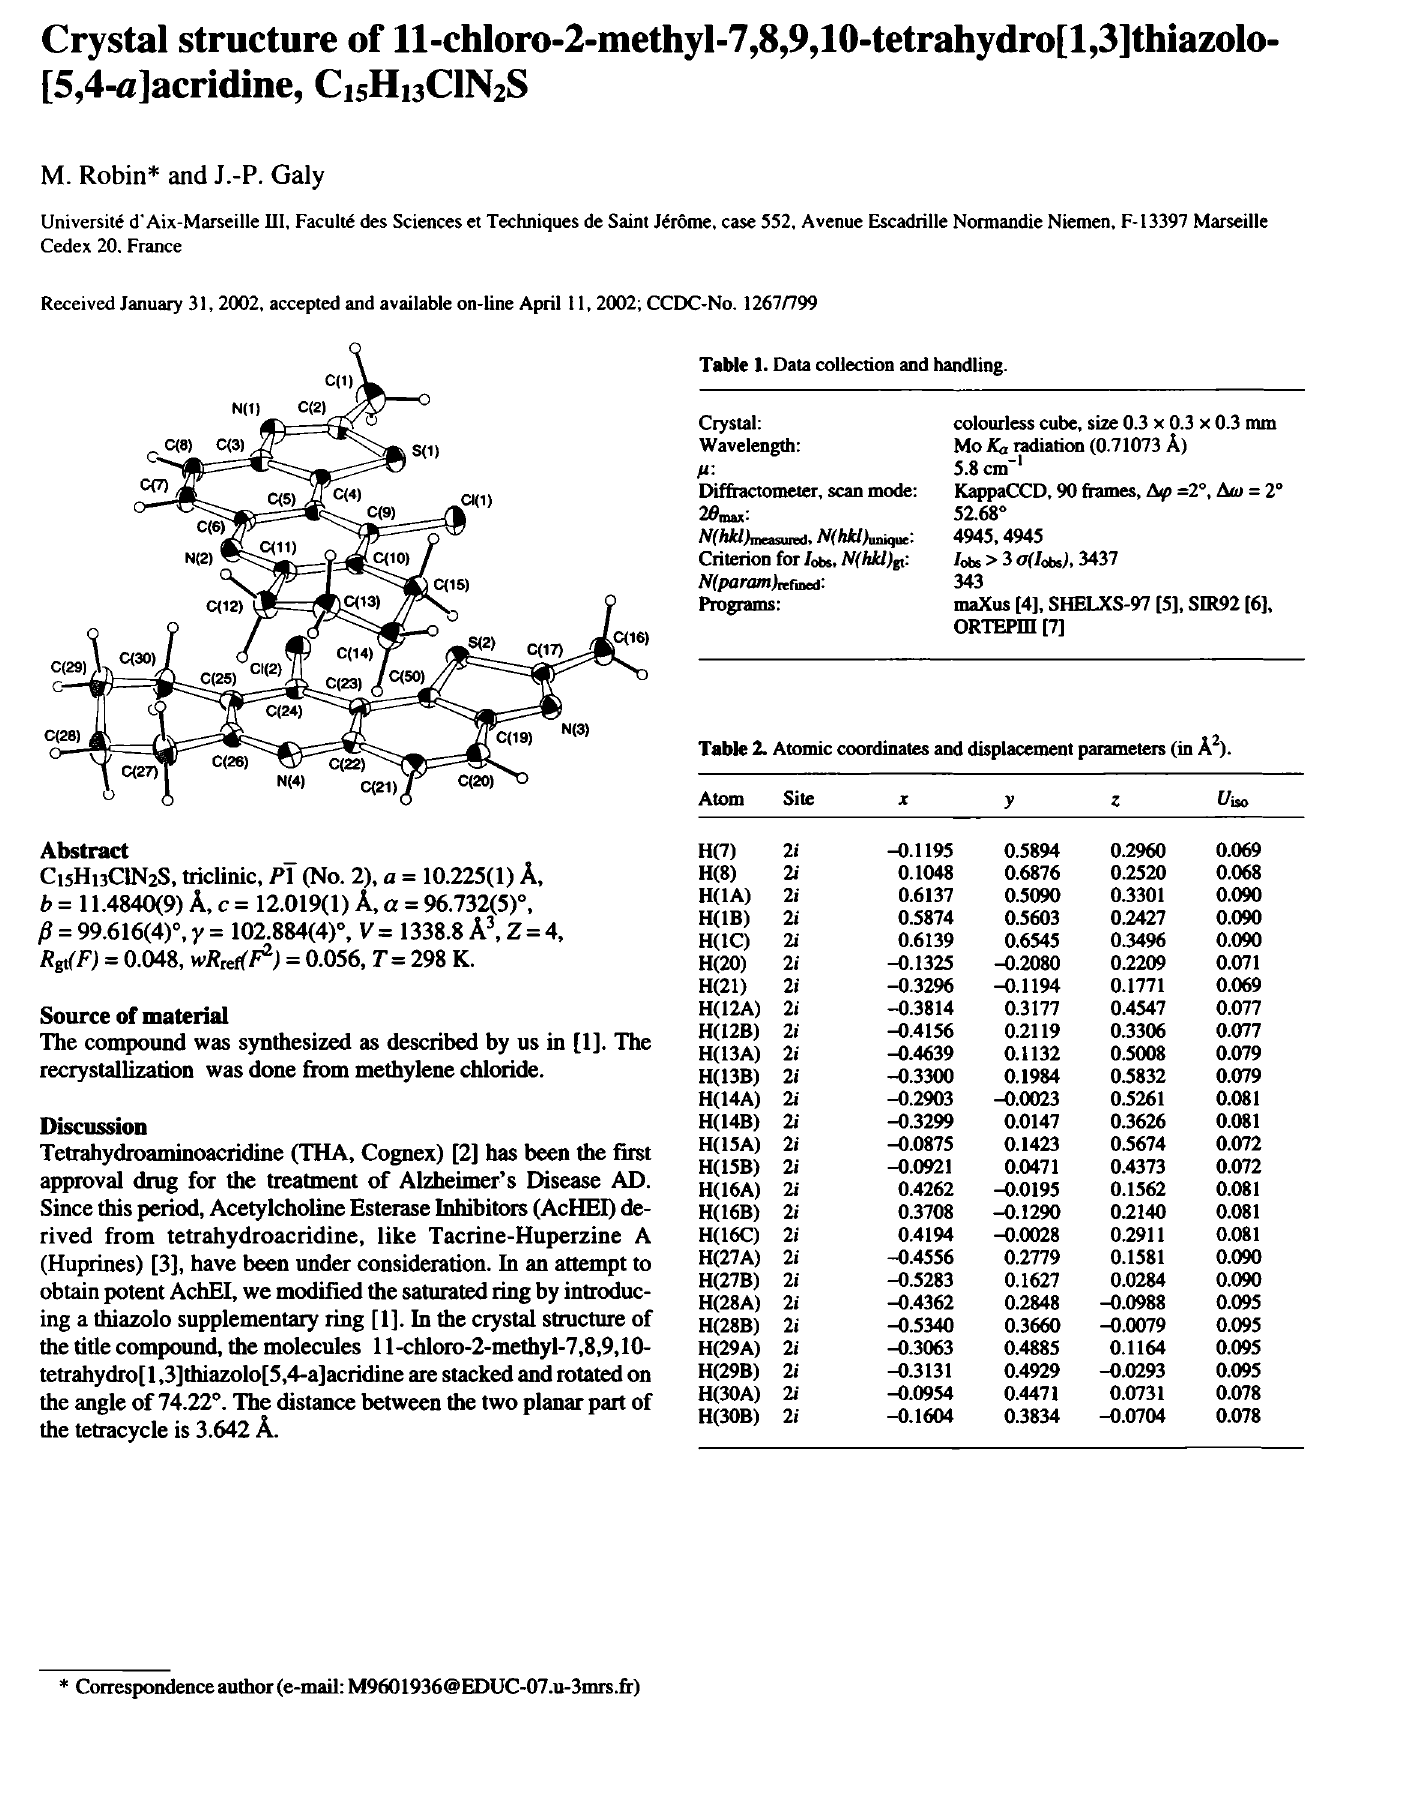
Table 1. Data collection and handling.